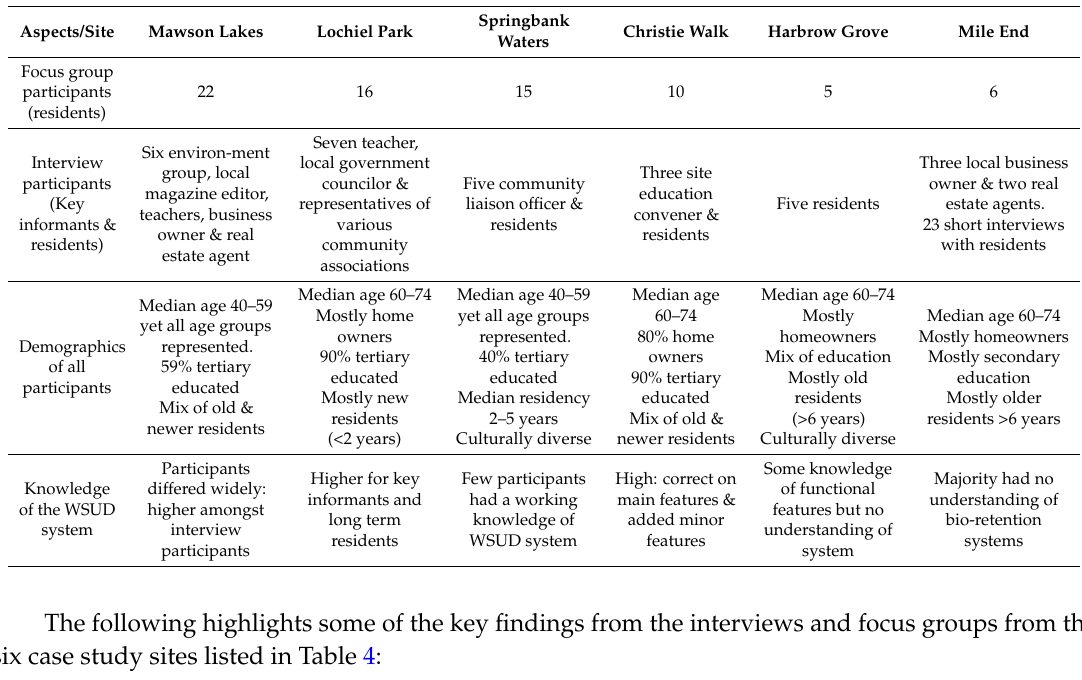
Table 4. Details of focus group and interview